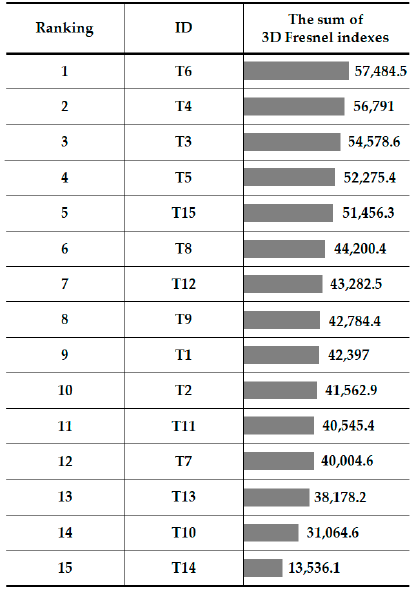
Figure 9. Ranking of the sum of the 3D Fresnel indexes for 15 transmitter candidates.